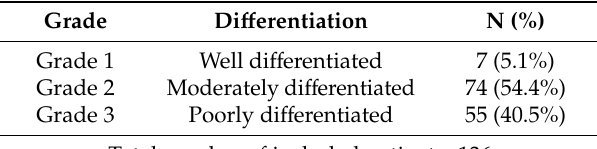
Figure 2. Histological patterns of lung adenocarcinoma. Representative hematoxylin and eosin-stained biopsy specimens: ( A ) lepidic-predominant pattern; ( B ) acinar-predominant pattern; ( C ) papillary- predominant pattern; ( D ) solid-predominant pattern; and ( E ) micropapillary-predominant pattern. Table 1. Adenocarcinoma subtyping according to the New IASLC grading